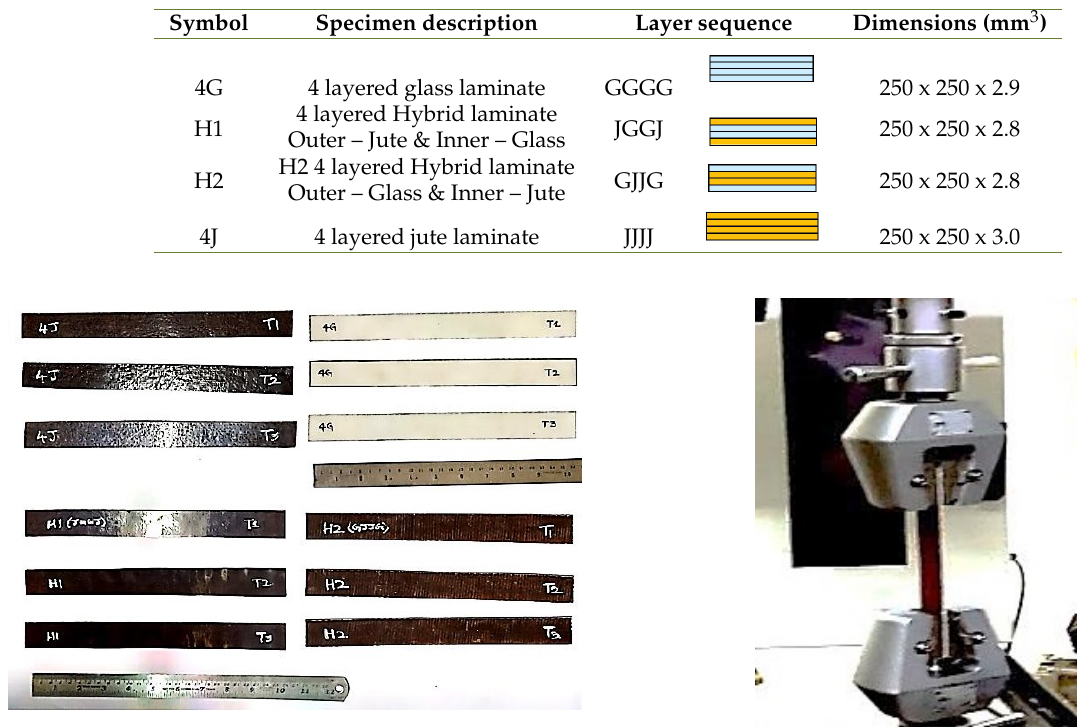
Fig. 2. Tensile test specimen of four types of composite laminates.